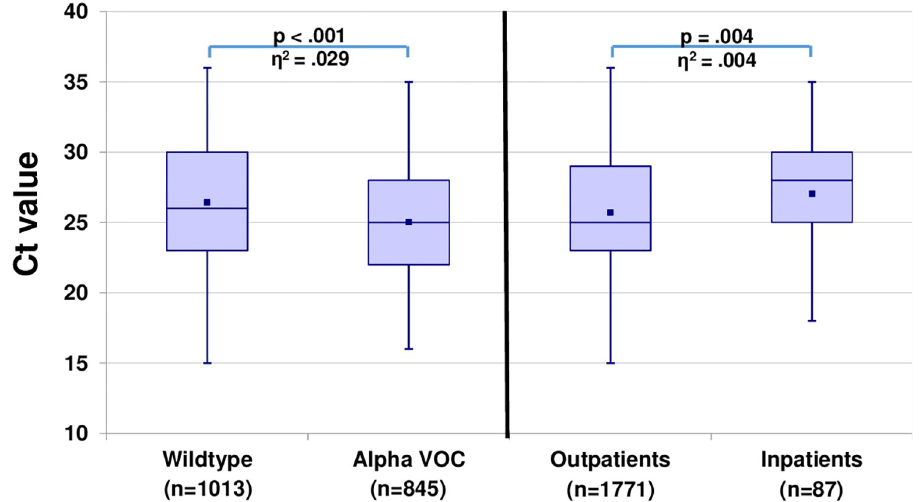
Fig 2. Box-Whisker-Plots of Ct values for SARS-CoV-2. (Left) Type of SARS-CoV-2. (Right) Clinical setting. Eta squared ( η 2 ) indicates the effect size.